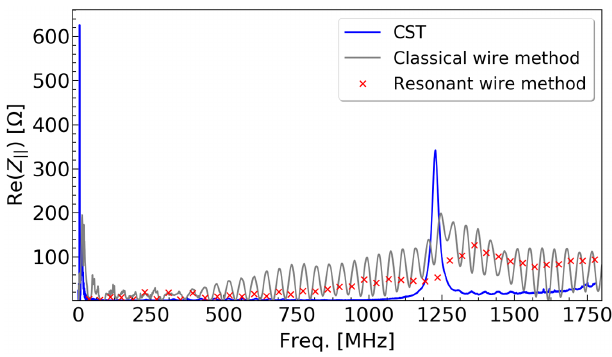
FIG. 20. Results of the real longitudinal impedance measure- ments performed on the LHC MKI with a prototype helical beam screen using classical and resonant single wire methods. The experimental data is compared with the CST